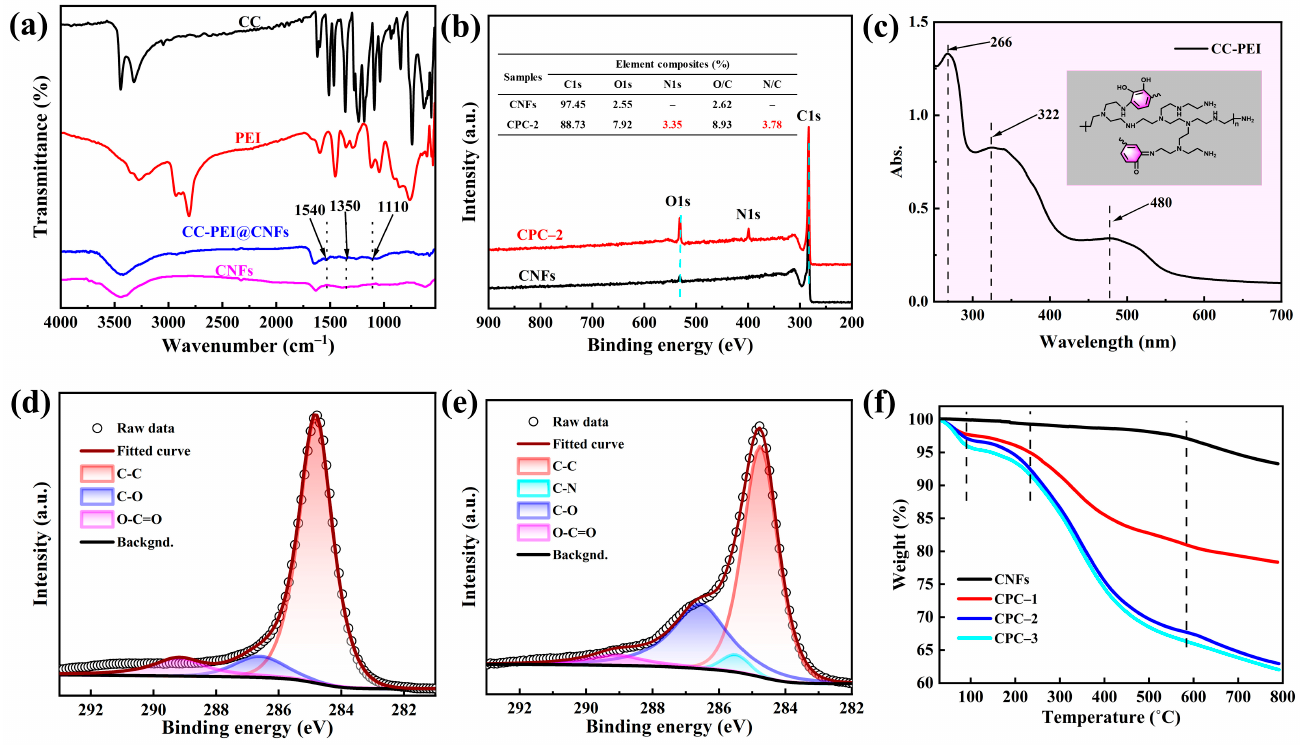
Figure 3. ( a ) FTIR spectra of CC, PEI, CNFs and CC-PEI@CNFs. ( b ) XPS full-scan spectra and element composition of the CNFs and CPC-2 ( c ) UV-Vis spectra of CC-PEI solutions after 36-h reaction. C1s peak fitting curves of ( d ) CNFs, and ( e ) CPC–2, ( f ) TGA spectra of CNFs, and different concentration gradient of CC-PEI to modify CNFs.